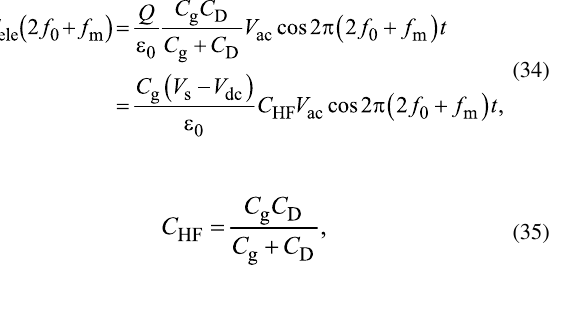
Figure 3c. Note that this equivalent circuit is equal to the equiv- alent circuit of the impedance of the MIS structure derived from the SRH model (Figure 3a), neglecting the capacitance compo- nent C it and resistance component R it due to the semiconductor interface